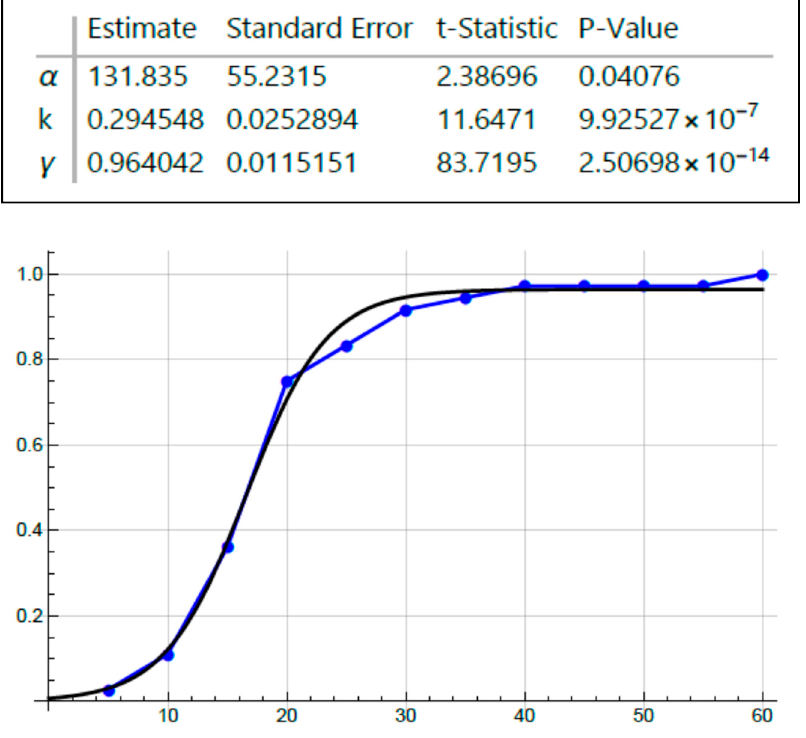
Figure 3. Fitting age-at-adenoma diagnosis data on FAP patients using the logistic equation.